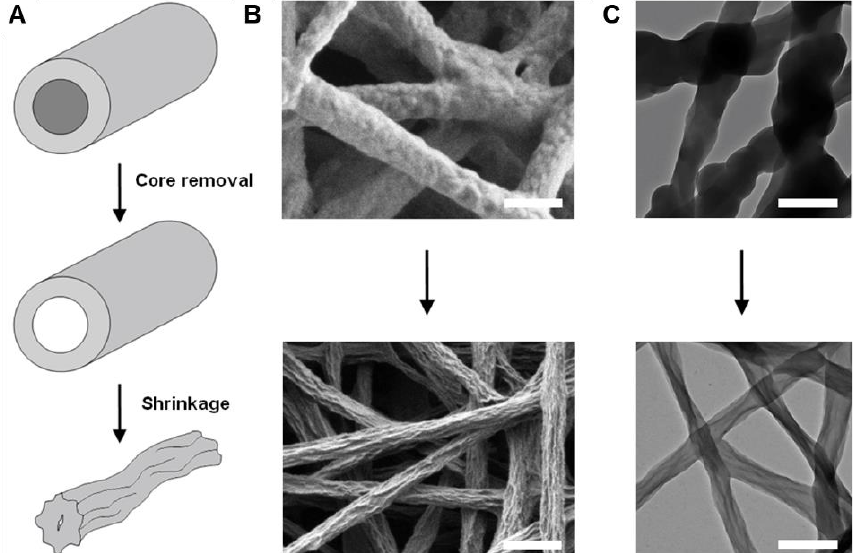
Figure 13. SEMs of ( A ) cellulose/PNVPy coated nanofibers and ( B ) cellulose/P3HT-coated nanofibers [245]. Republished with permission from Ref. [245], Permission conveyed through Copy- right Clearance Center Inc.